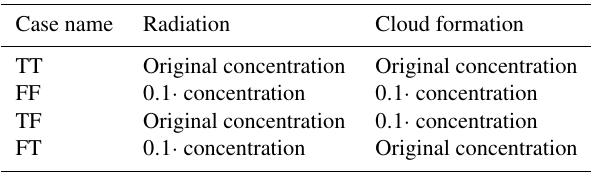
Figure 5. Schematic overview of the simulations that were per- formed as a preparation for the simulation of the analysis period. Table 5. Simulations performed for this study and the mineral dust concentration used to calculate radiation and cloud